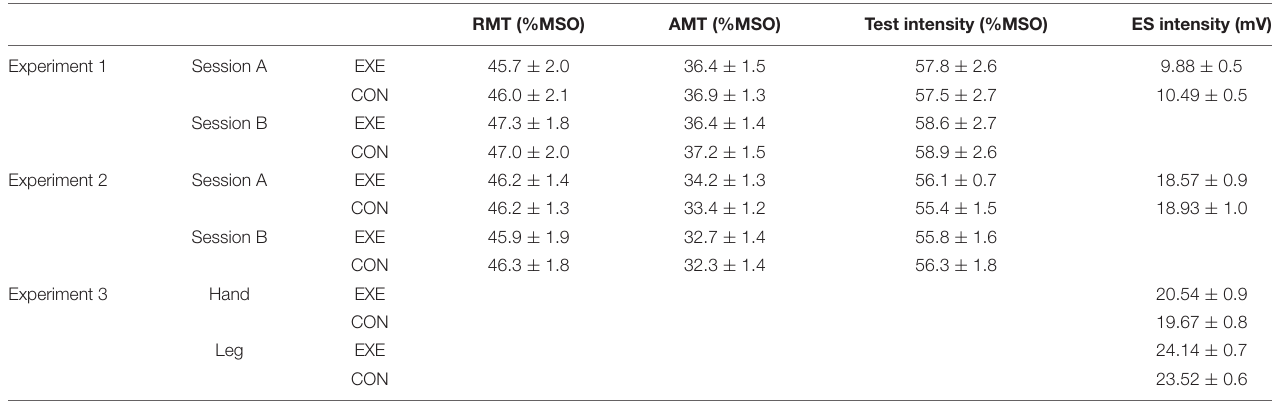
(Experiment 1: 1 mV, Experiment 2: peak-to-peak amplitude elicited by 120%RMT). In this case, both single-pulse MEP at baseline intensity and that at adjusted intensity were